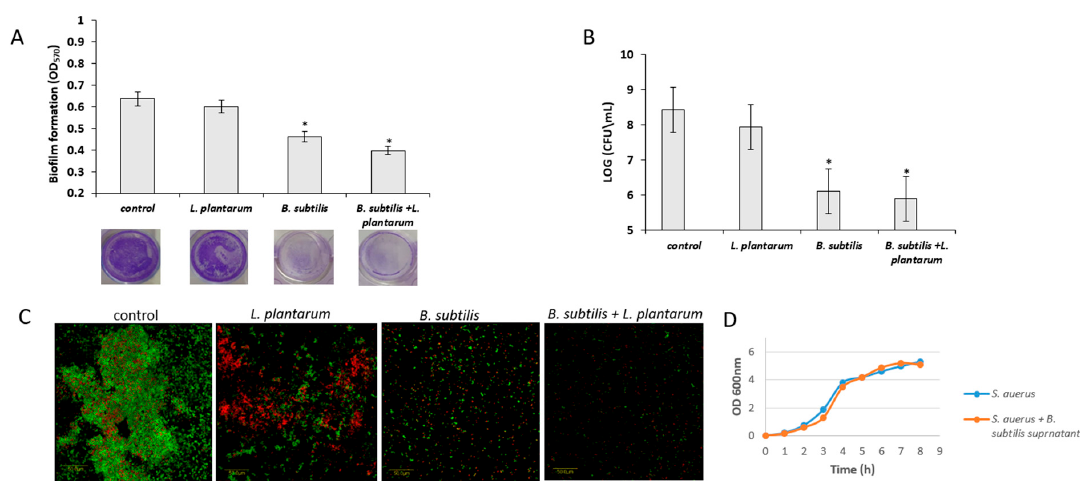
Figure 7. Conditioning supernatant (CNS) of the B. subtilis culture inhibits biofilm formation by Staphylococcus aureus . S. aureus biofilm formation was determined after growth in TSB medium with 10% CNS at 37 ◦ C for 24 h. ( A ) S. aureus biofilm formation quantification by crystal violet method. ( B ) Quantification of live bacteria attached to surface using CFU method. * p < 0.05 for comparison of the control and tested samples. Error bars represent standard deviation (SD). ( C ) Confocal laser microscopy (CLSM) images of S. aureus biofilms formed onto polystyrene surfaces containing 10% CNS. Live cells (SYTO-9, green) and dead cells (propidium iodide, red). Scale bar = 50 µ m. ( D ) S. aureus growth curve in TSB medium supplemented by the 10% CNS generated from the B. subtilis growth medium .